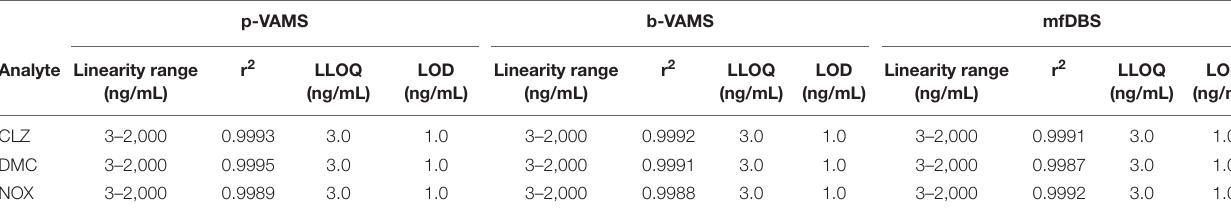
TABLE 1 | Linearity, LLOQ, and LOD results on VAMS and mfDBS spiked samples. p-VAMS b-VAMS mfDBS Analyte Linearity range (ng/mL)